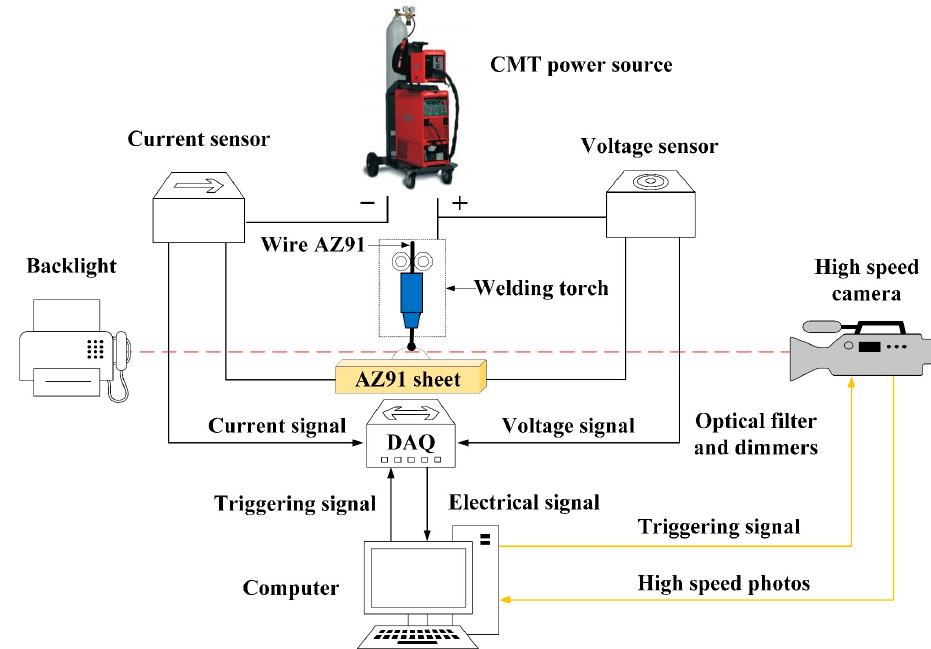
Figure 1. Schematic of the acquisition system.